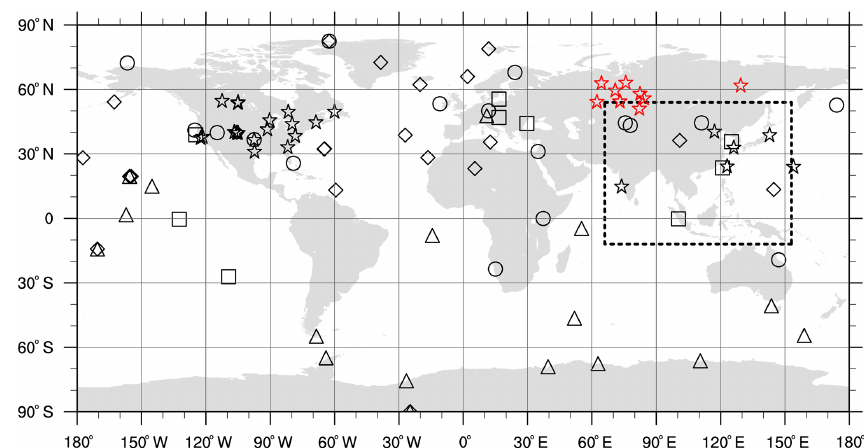
Figure 1. Observation networks of CO 2 concentrations around the globe and the nested domain of the TM5 transport model over Asia (dashed box). Each observation site is assigned to different categories ( (cid:52) : MBL; (cid:13) : continental; (cid:5) : mixed land/ocean and mountain; ☆ : continuous; (cid:3) : difficult). JR-STATION observation sites are represented in